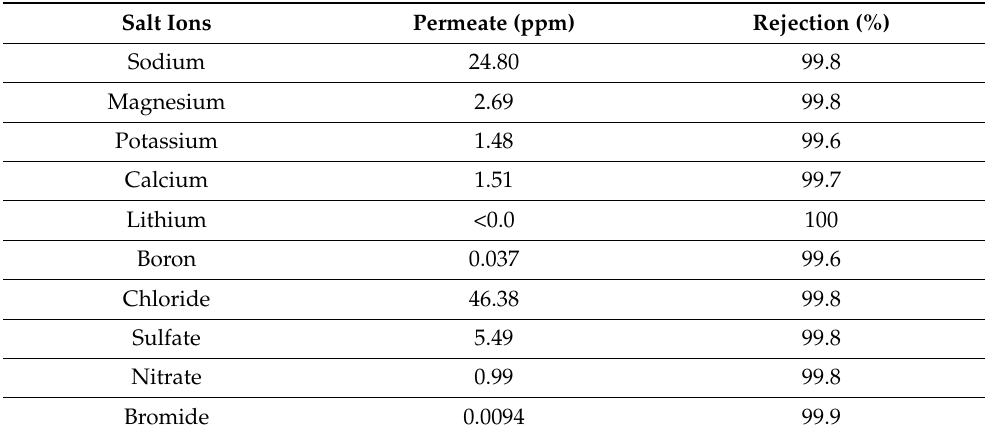
Table 4. Amount of inorganic salt ions present in the permeate from the DCMD process and the percentage